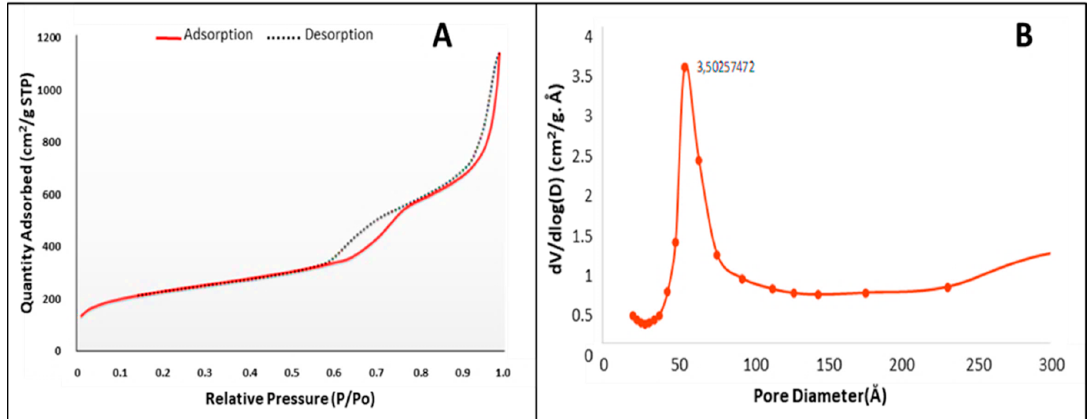
Figure 2. ( A ) Nitrogen adsorption-desorption isotherm and ( B ) pore size distribution of MSN.